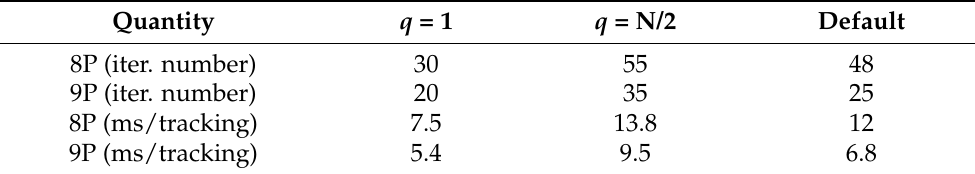
Table 2. Time performances of 8P and 9P, in the case of next-neighbor guess, in case of diametrically opposite guess and in case of default values assigned programmatically (see Table 1).